Question: Give a one-sentence summary of this figure.
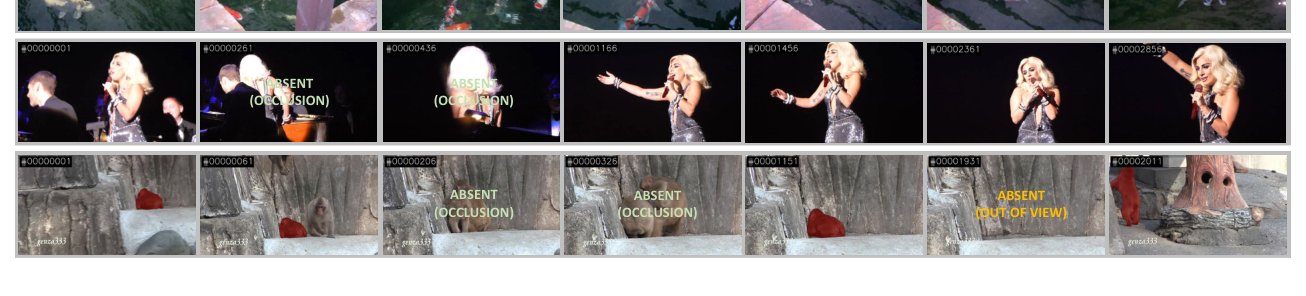
Answer: Example sequences of our Large-scale Long-term Video Object Segmentation (LVOS). Compared to previous video object segmentation datasets, LVOS presents greater challenges, with the main difficulties stemming from longer video durations, intricate scenes, frequent disappearance and reappearance of objects, Cross-temporal confusion, and small objects. Text in green denotes that target object is occluded, while text in orange denotes that target object is out-of-view.